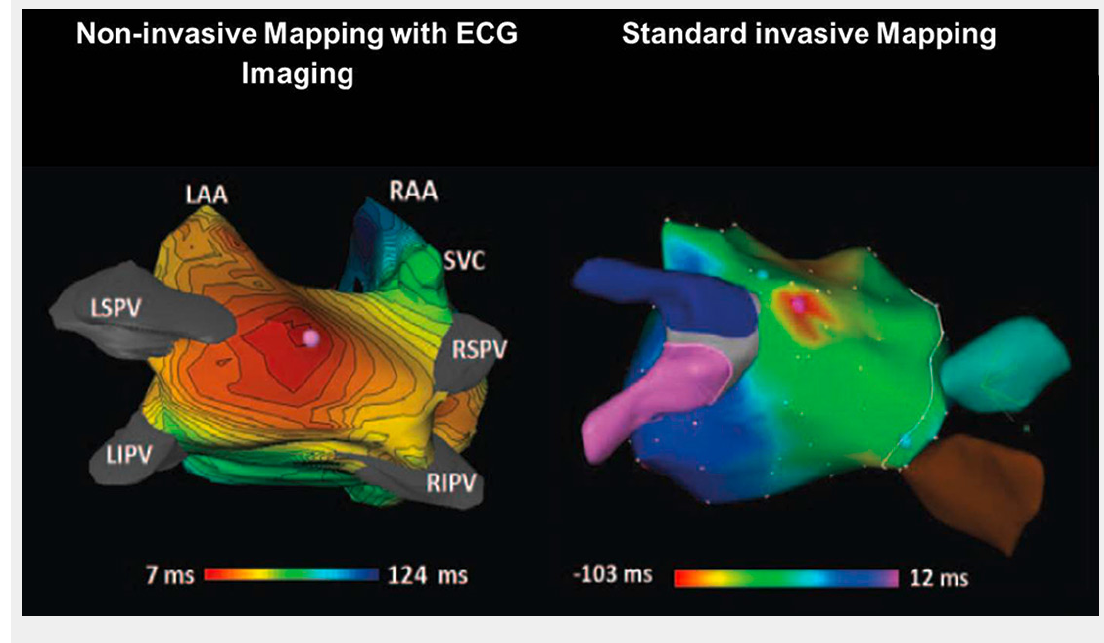
Maps obtained from ECG mapping and standard invasive mapping in a patient with incessant atrial tachycardia. On the left side of the figure, the map obtained with ECG mapping demonstrated focal activation of the left atrium, with the earliest site of activation on the left atrial roof. On the right side of the figure, the CARTO map with the site of successful ablation that terminated the tachycardia. As can be appreciated, the ECG mapping techniques successfully identified both the tachycardia mechanism as well as the site of earliest activation (reproduced from Cakulev et al. [66] with permission). LAA = left atrial appendage; LIPV = left inferior pulmonary vein; LSPV =left superior pulmonary vein; RAA = right atrial appendage; RSPV = right superior pulmonary vein; RIPV = right inferior pulmonary vein; SVC = superior vena